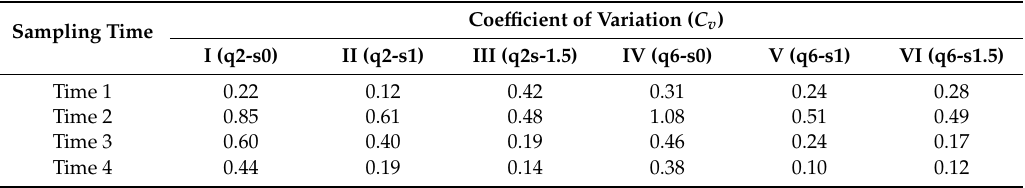
Table 4. Statistical characteristics of the distribution of SO 2 each times.